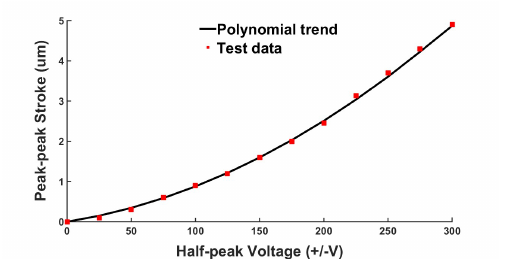
Figure 10. Free displacement of the shear piezoelectric stack from − V to +V voltage.